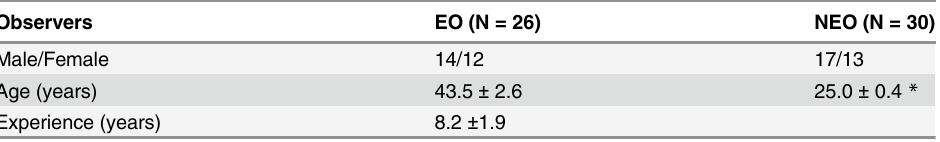
Table 1. Main characteristics of the observers (data are means ±